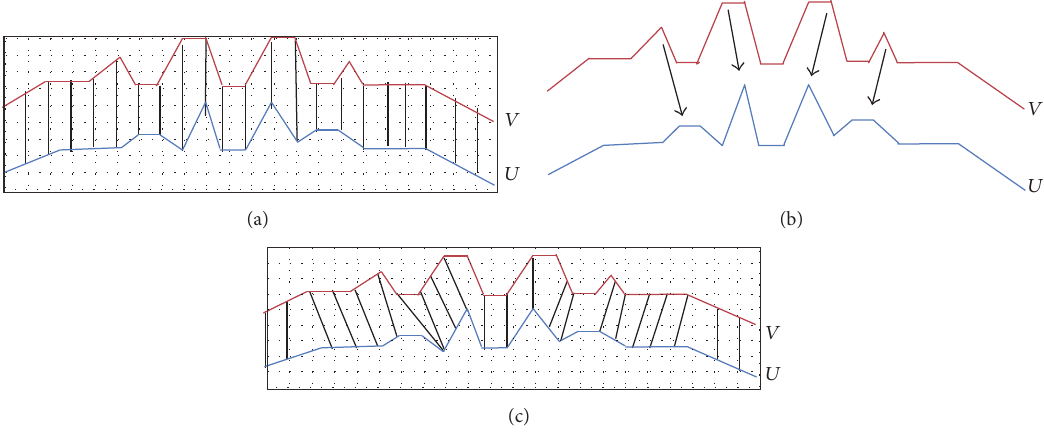
Figure 3: An example of distance measurements between two time series using Dynamic Time Warping [26]. (a) Euclidean distance measurement between two time series. (b) DTW attempts to warp in time axis to find the correct measurement. (c) Distance measurement using